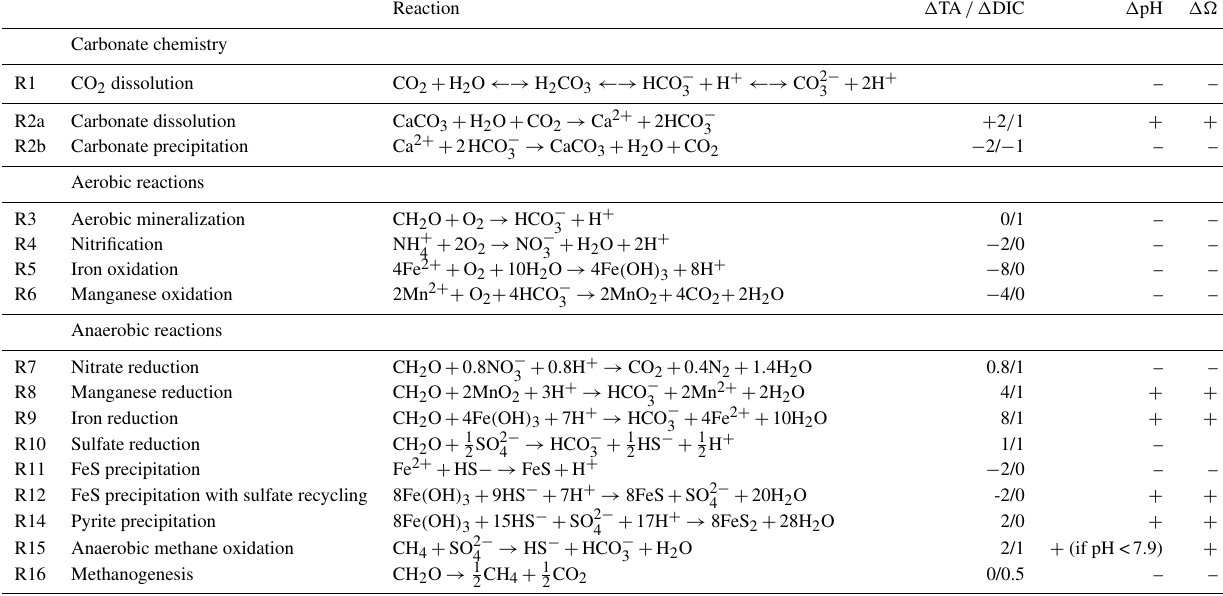
Figure 6. Calculated pH t porewater profiles of the proximal, the prodelta and the distal domains. The error bars are estimations of the error propagation from the measured data in the calculation. Table 2. Diagenetic reactions and their effect on the carbonate system (TA, DIC, pH and (cid:127)) .